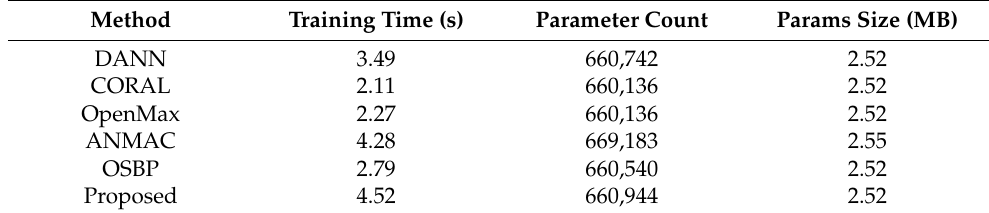
Table 8. The analysis of the complexity and computation